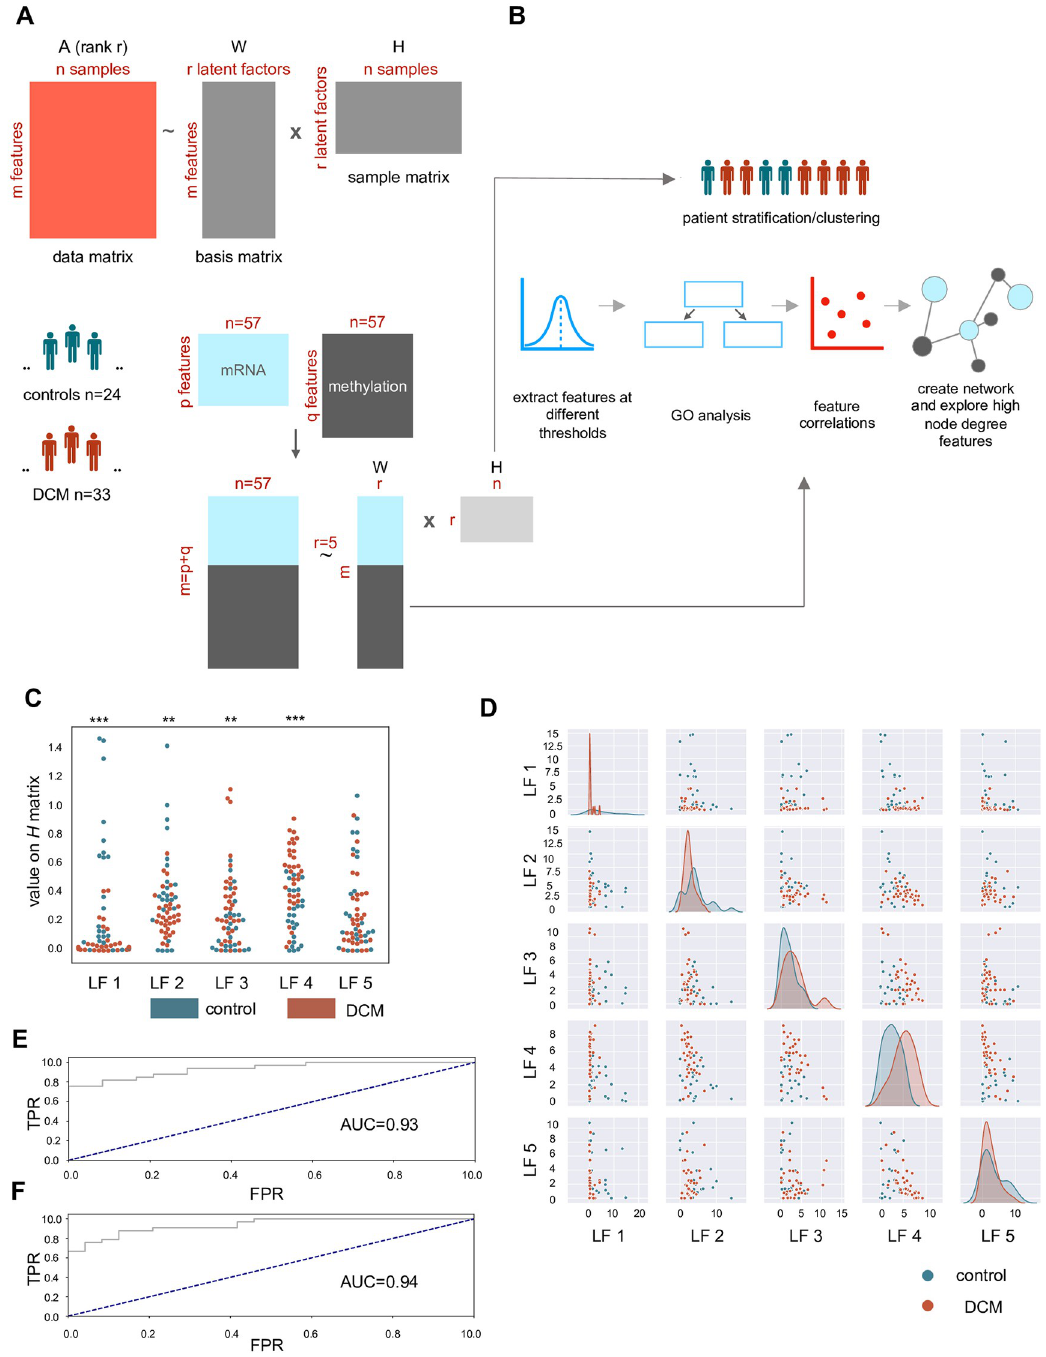
Fig 1. Overview of matrix factorization and distribution of latent factors. A) The general concept of matrix factorization is detailed in the figure. Matrix A with m features and n samples can be decomposed at rank r in two matrices, one signifying the relationship of the original features with the latent factors ( W matrix) and another signifying the relationship of the latent factors and the samples ( H matrix). The cohort with 24 control and 33 DCM samples is profiled for gene expression and methylation and matrix factorization is carried out on the combined methylation and gene expression data matrices at rank 5. B) The H matrix is used for clustering of patients and determining the potential of the latent factors in discriminating DCM from control samples. From the W matrix, features with high loadings above a threshold (90 th percentile) are selected and GO analysis is performed, followed by correlations and network analysis. C ) Swarm plot of latent factor values. ��� = P < 0.0005, �� = P < 0.005 as per a Mann- Whitney U test. D ) Scatterplots of the latent factors show the pairwise distribution of latent factor values for DCM and control samples. E ) Receiver operating characteristic curve for differentiating between DCM and control with the 5 latent factors. TPR = true positive rate. FPR = false positive rate. F ) Receiver operating characteristic curve using 4 significant latent factors.